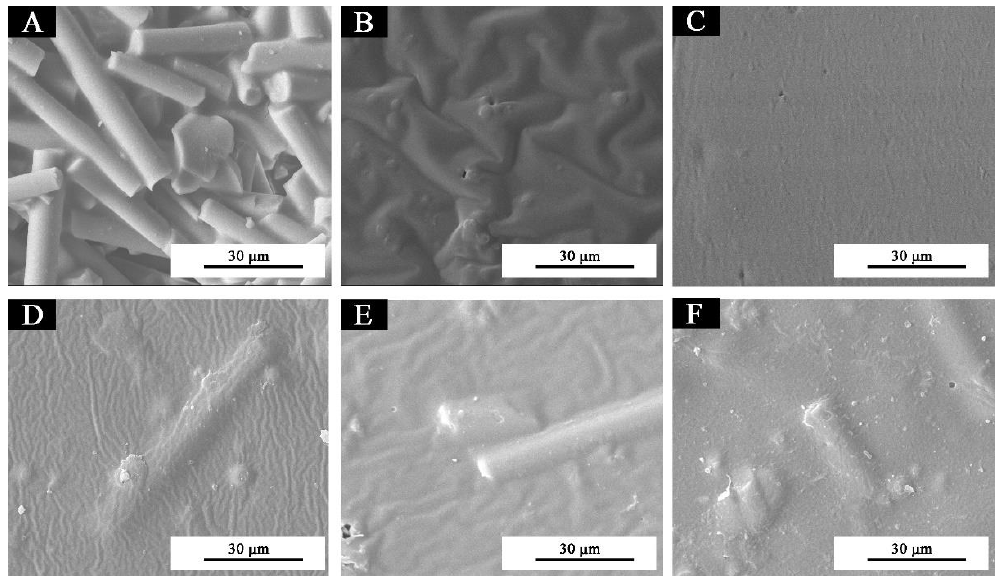
Figure 1. SEM of the waterborne coatings with thermochromic ink and different concentrations of glass fiber powder: ( A ) glass fiber powder, ( B ) thermochromic ink, ( C ) pure coating, and ( D – F ) 1.0%, 3.0%, and 10.0% glass fiber powder in the waterborne coating with thermochromic ink, respectively. Polymers 2019 , 11 , x FOR PEER REVIEW